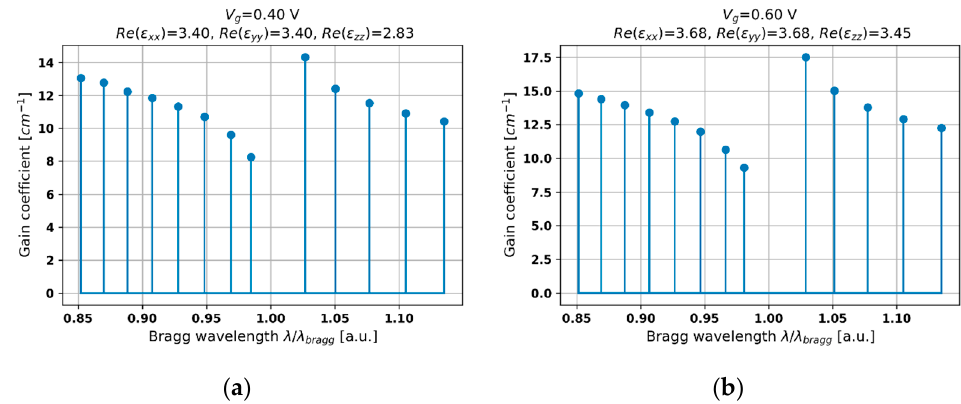
Figure 5. Threshold modal spectra for PHC structures with HMM structures revealing elliptic dispersion and biased with external voltage V g = 0.4 V ( a ) and 0.6 V ( b ).